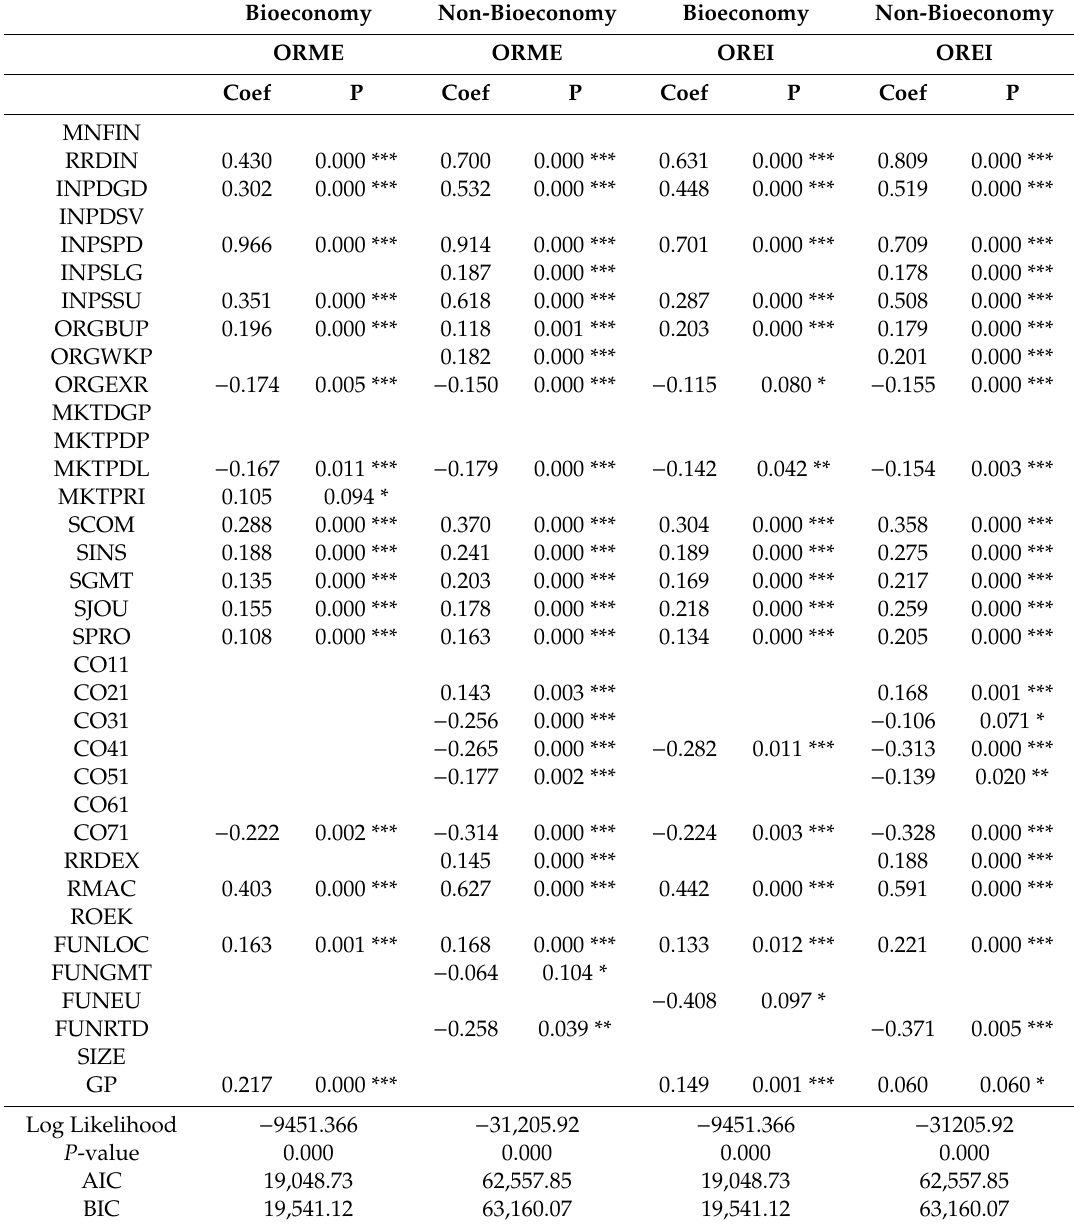
Table A4. Estimation results of multivariate tobit model